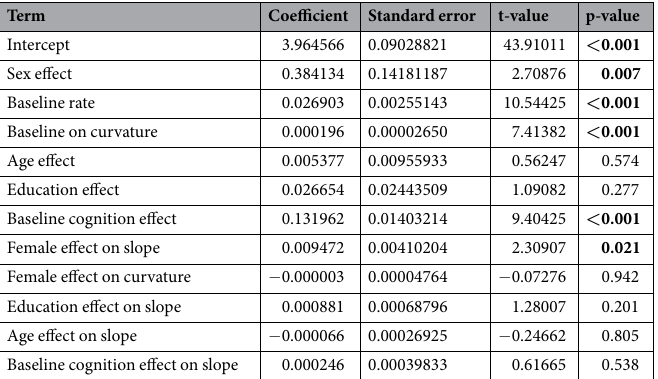
Table 4. Effects of Sex on ADAS-Cog11 change in MCI due to AD – high likelihood. CSF t-tau/A β 42 ratio was used to identify subjects with MCI due to AD – high likelihood. Baseline cognition indicates ADAS-Cog 11. Bold p -values are statistically significant. Abbreviations: MCI (mild cognitive impairment), ADAS-Cog11 (Alzheimer’s disease assessment scale- cognitive subscale). In this model, the follow-up time (month) was centered with the median follow-up time (36 months) and covariates were centered i.e. a 75 years old with 16 years of education and an ADAS-Cog11 of 11. The effect of sex was significant with females declining faster than males. The intercept is a term to get the correct estimate of the outcome when time = 0. The baseline rate is the reference population rate of change in the outcome starting at time zero, and the baseline curvature is the “acceleration” of that rate of change at time zero. The upper half of the table shows the effect of specific variables on ADAS-Cog11 and the bottom half shows their effects on ADAS-Cog11 slope and